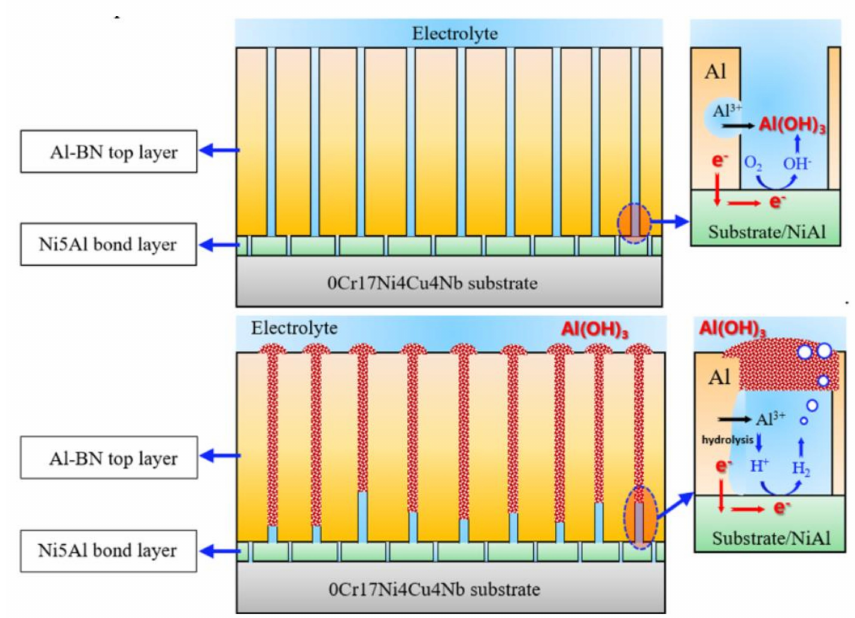
Figure 14. Schematic presentation of the galvanic corrosion development of the Al–BN